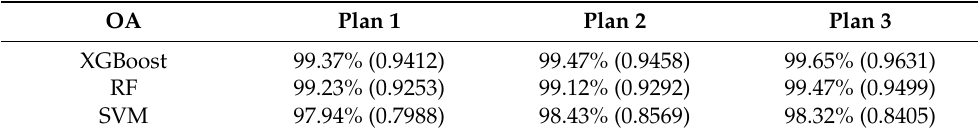
Table 5. Data for the overall accuracy and macro F1_score (in brackets) associated with different classification